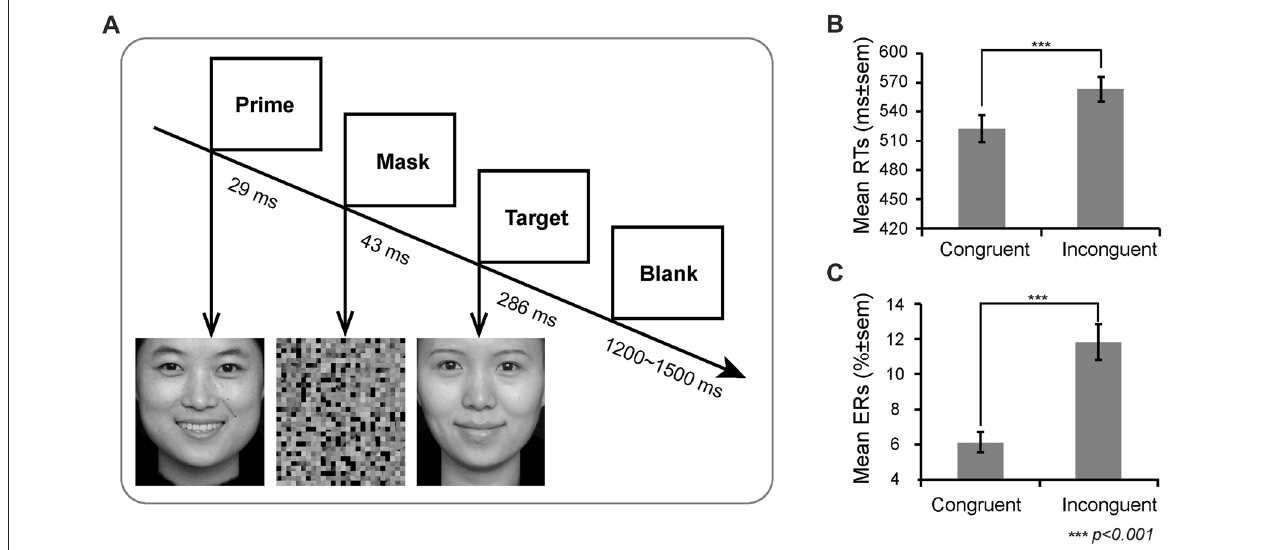
FIGURE 1 | Experimental design and behavioral results. (A) Schematic representation of the task and stimuli. The valence of prime and target facial expressions could be congruent or incongruent (50/50 congruent/incongruent trials). The mean (B) Reaction times (RTs) and (C) Error rates (ERs) as a function of congruency.